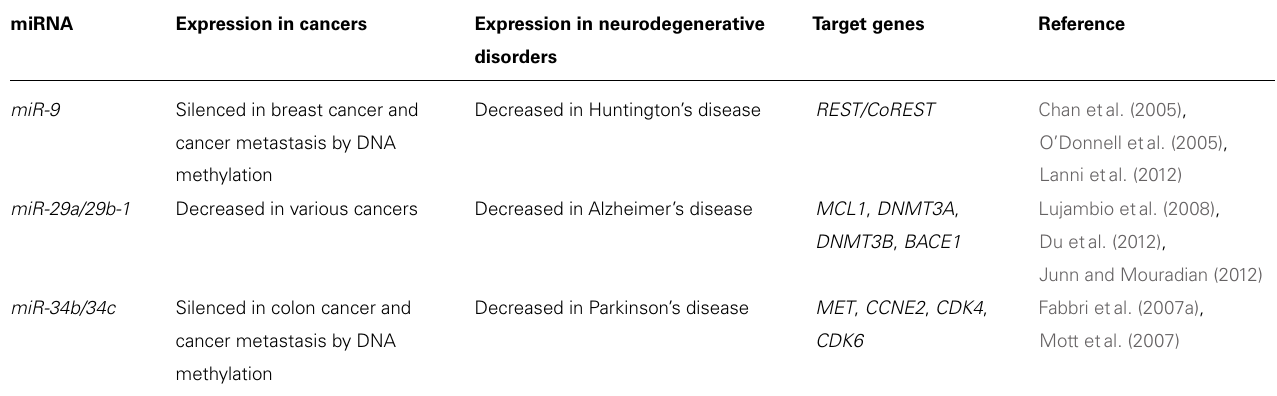
Table 1 | miRNAs differentially expressed in cancers and neurodegenerative